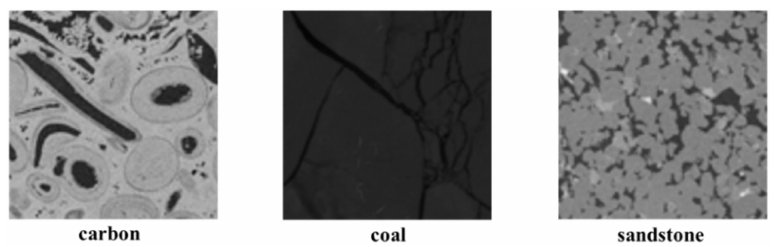
Figure 9. Testing